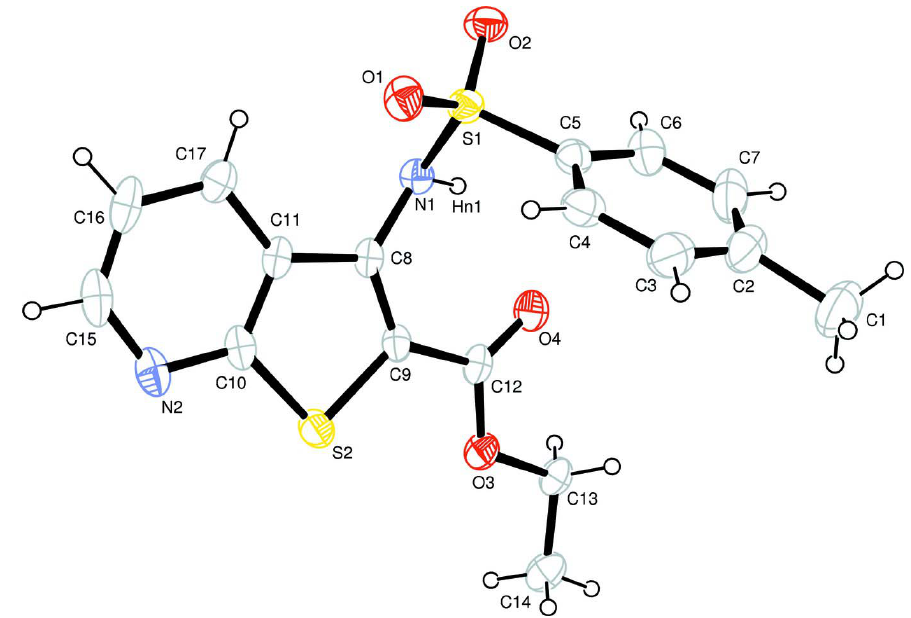
Figure 1 The molecular structure of the title compound, with displacement ellipsoids drawn at the 30% probability level.